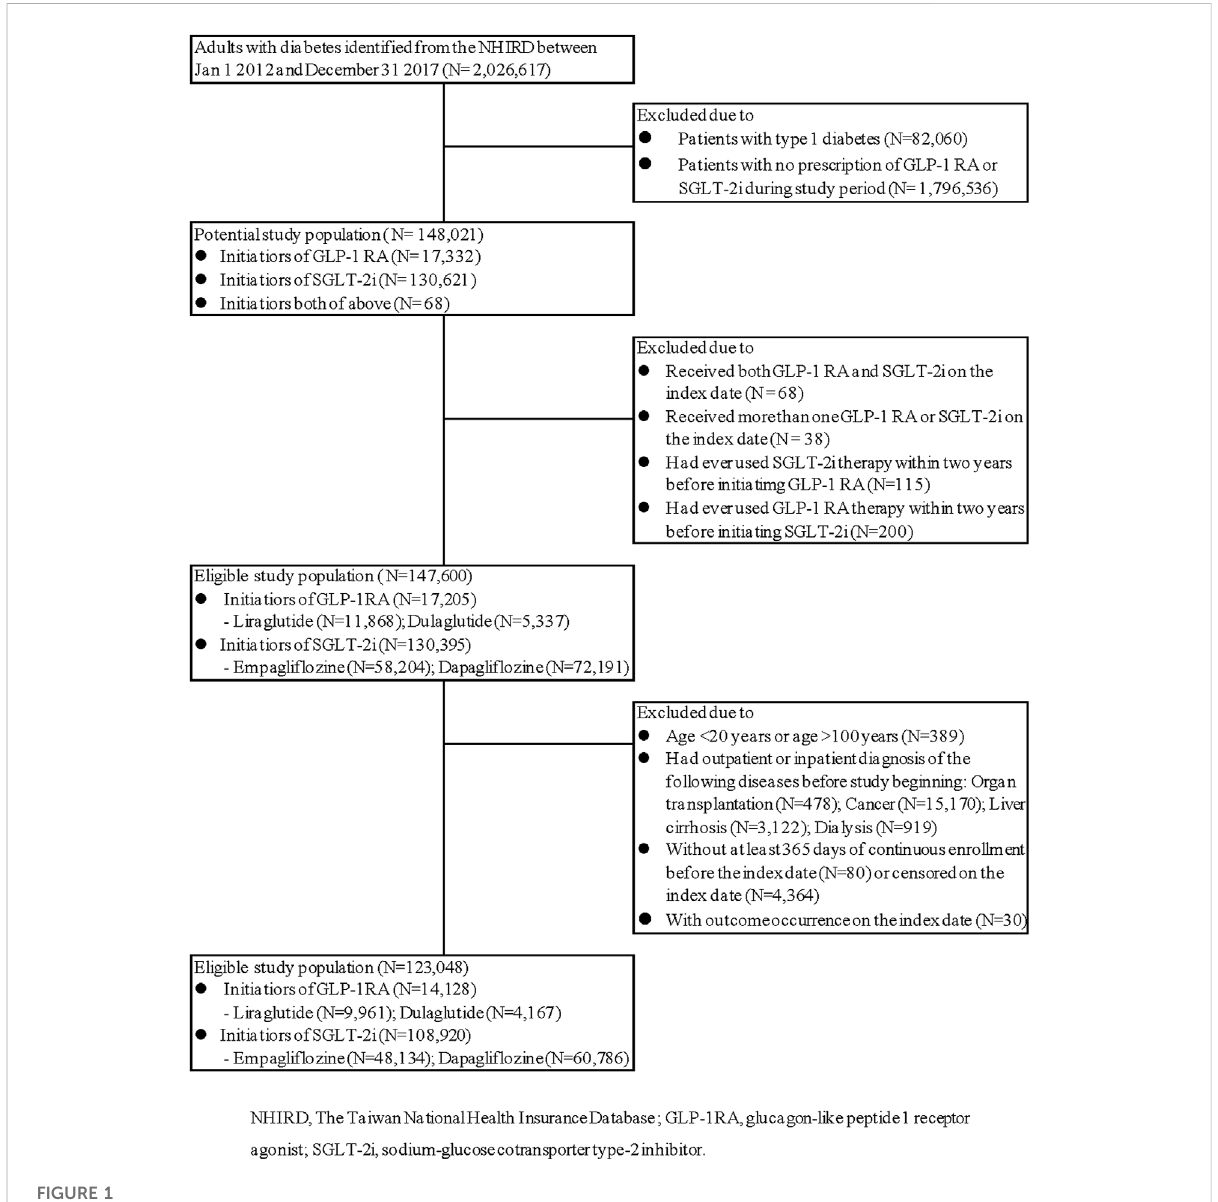
FIGURE 1 Study cohort assembly. (SGLT-2i versus